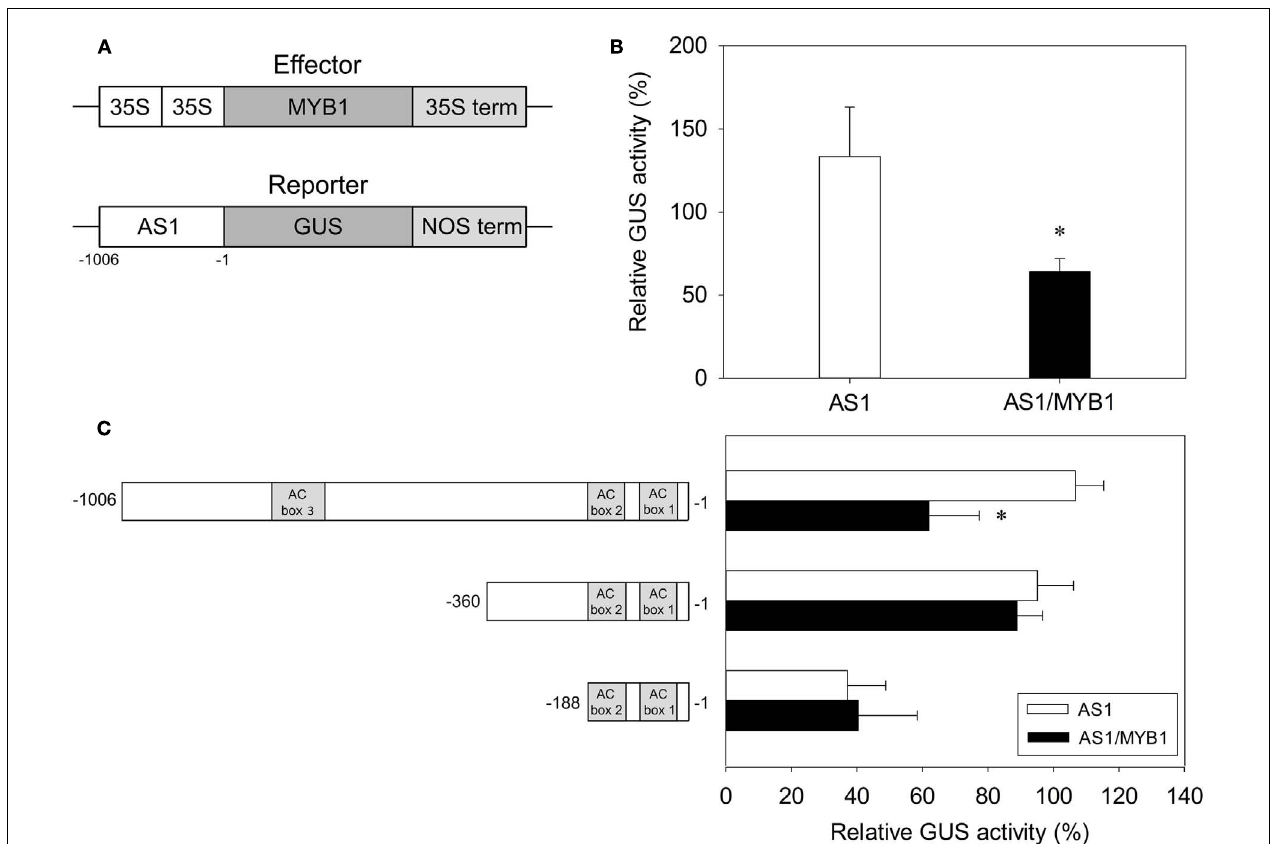
FIGURE 7 |Transcriptional regulation of PpAS1 by the PtMYB1 transcription factor in pine cells. (A) Schematic representation of the effector and target constructs. (B) Transient expression assays were performed by co-transforming reporter (PpAS1 pro :GUS) and effector (35S pro :PtMYB1) plasmids at a molar ratio of 1:1 into protoplasts from pine cotyledons. Relative GUS activity was expressed as percentage of the GUS activity compared with control construction (35S pro :GUS). Bars indicate the